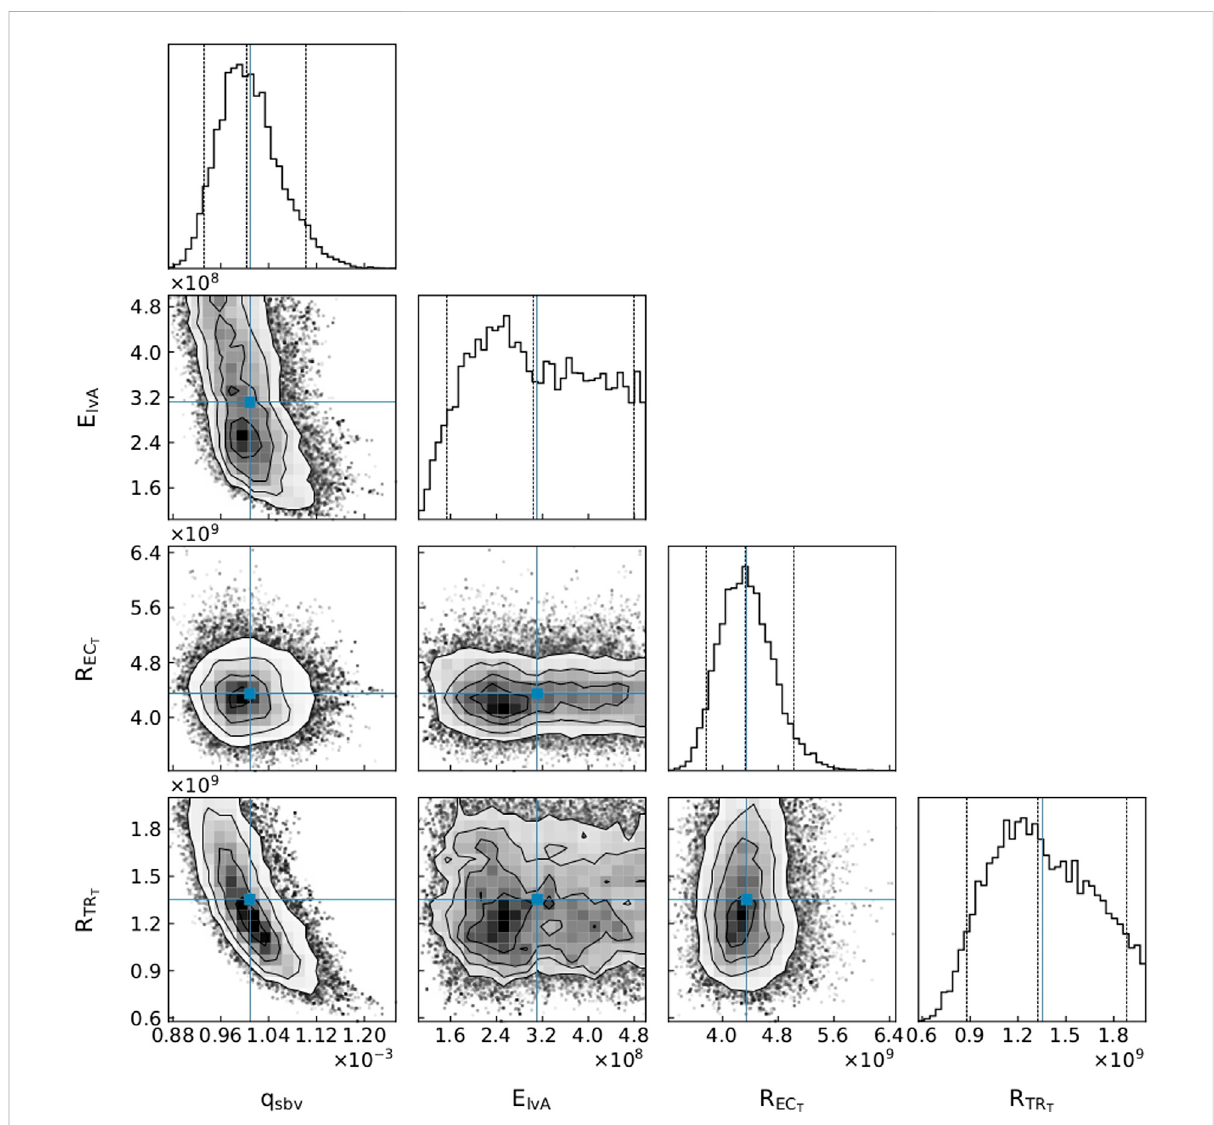
FIGURE 6 A subset of parameter distributions for Patient 3. q sbv : stressed blood volume, E lvA : left ventricle maximum elastance, R EC T : external carotid terminal resistance, R TR T : trunk terminal